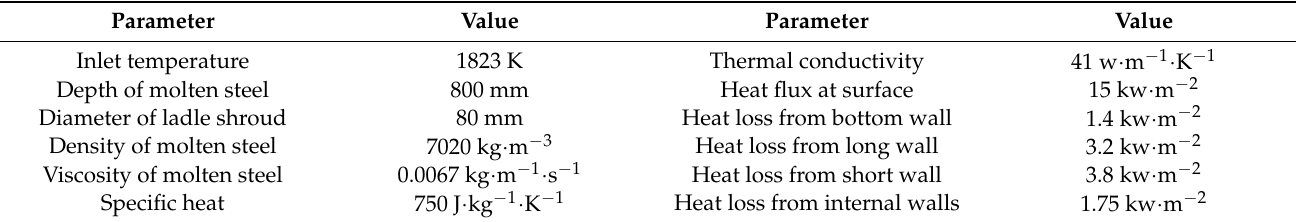
Table 3. Parameters and boundary conditions used in